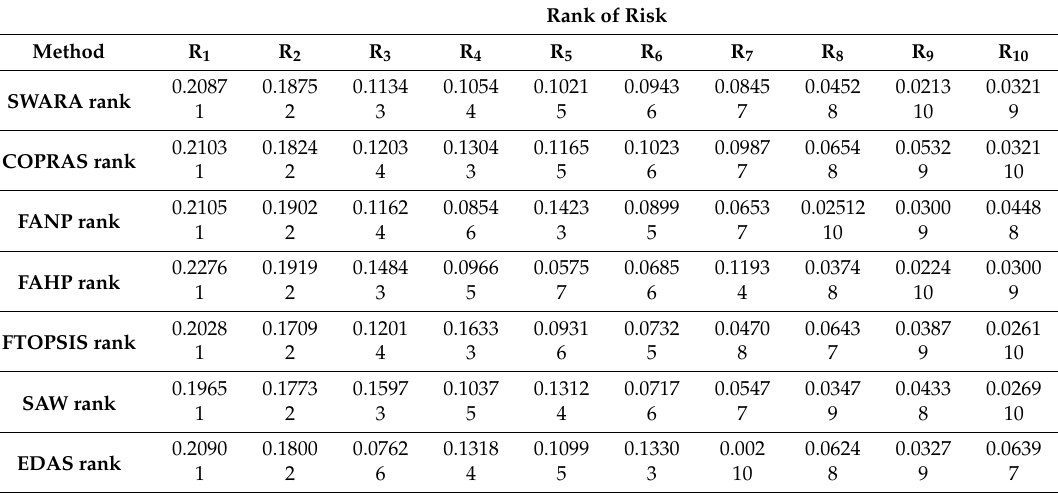
Table 5. Final risk rankings for the MADM